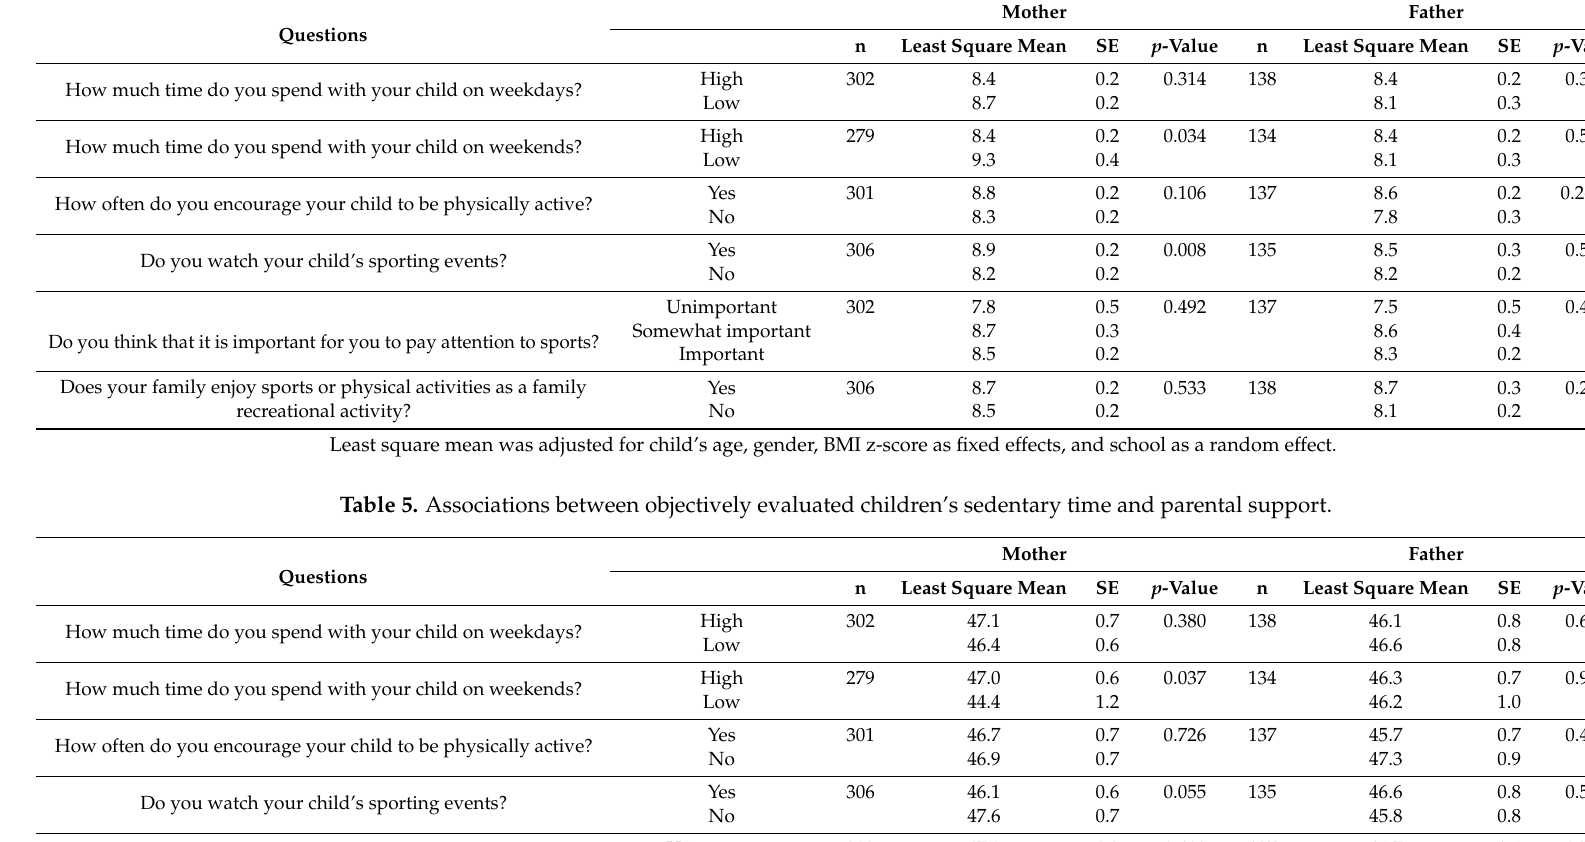
Table 4. Associations between objectively evaluated children’s total moderate-to-vigorous physical activity and parental support. Questions